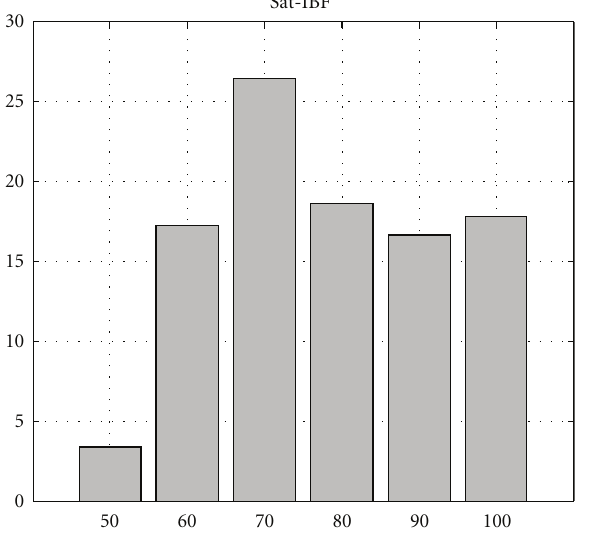
Figure 8: Satisfaction histogram IBF-MKP algorithm with priority- oriented scaling scheme.